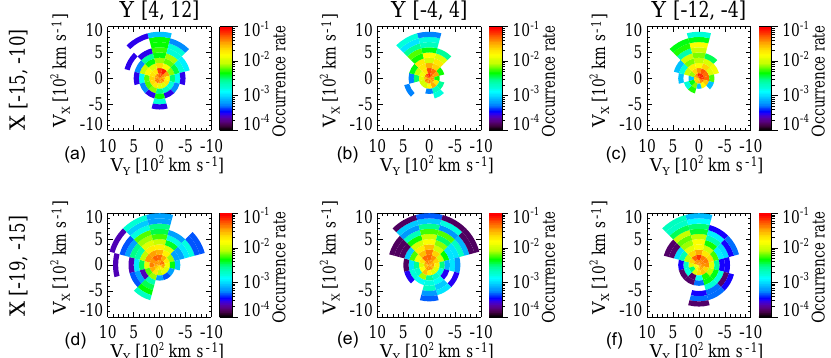
Figure 8. The ion velocity distributions of the DF events from C1 in different regions. The value in each bin is determined by the data number of this bin divided by the total data number in that region. The ion velocities for each DF are selected in the interval between t DF and t DF + 5min.